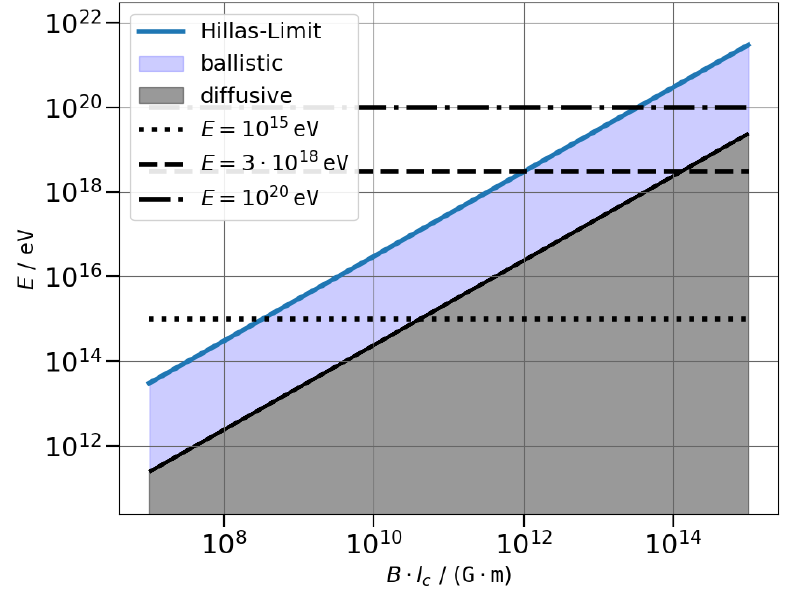
Figure 2. Illustration of the transition between the quasi-ballistic regime (in blue) and the resonant scattering regime (in grey) in the dependence of the magnetic field strength, B , correlation length of the magnetic field, l c , and particle energy, E . In a simplified approach, it is assumed here that particles in the quasi-ballistic regime propagate ballistically and in the resonant scattering regime diffusively. The position of the diagonal line represents the transition energy from diffusive (below) to ballistic (above) for protons (the atomic number Z = 1), determined by Equation (1). Diffusive propagation is expected for the result of a parameter combination below the line, while ballistic propagation lies above the